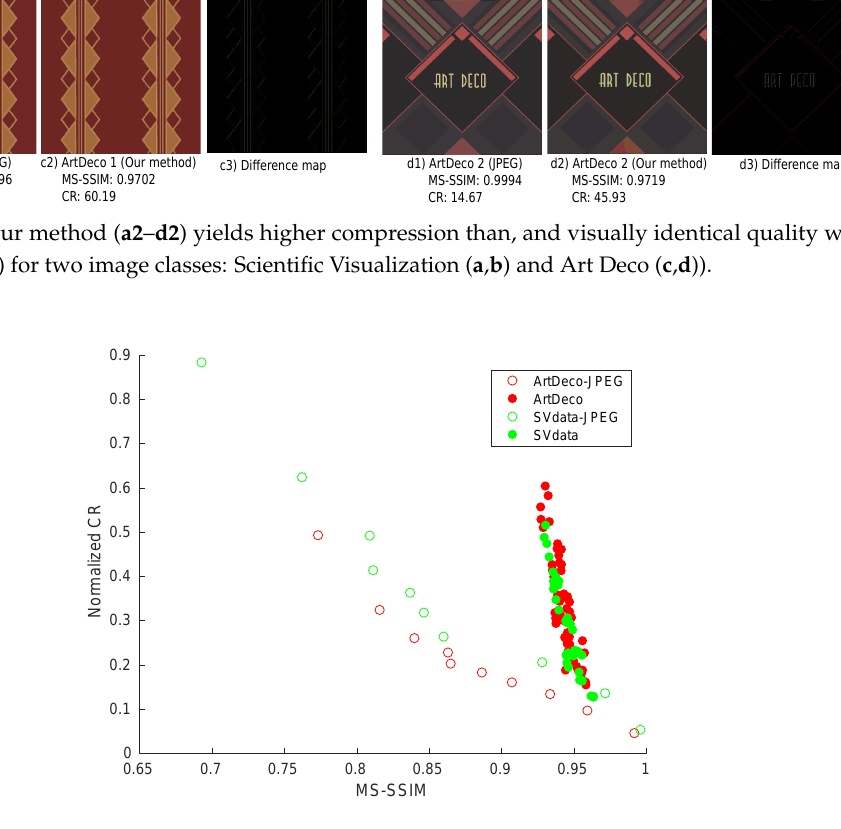
Figure 11. Average MS-SSIM vs. CR for two image classes (Art Deco, Scientific Visualization), for our method (filled dots) and JPEG (hollow